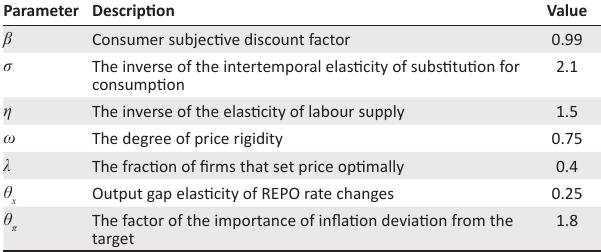
TABLE 1: Calibrated